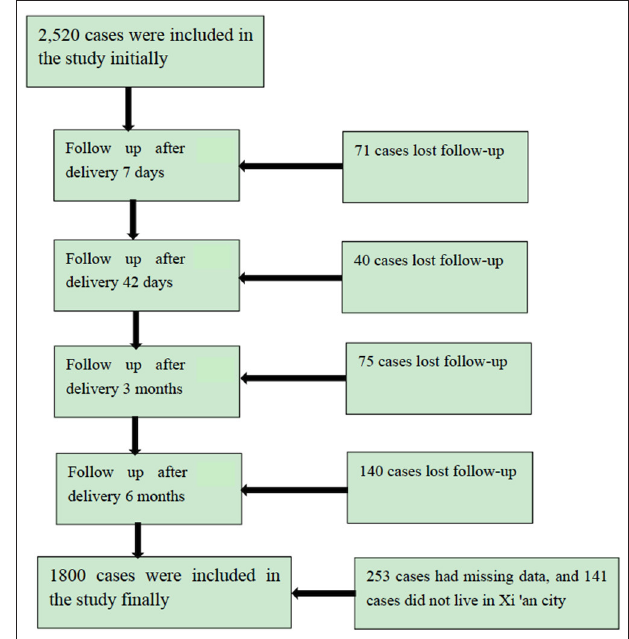
FIGURE 1 | Follow-up flow